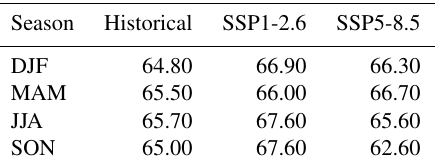
Table 2. Relative area coverage by tropical classes (3 + 4) as com- bined regions during each season (shown as